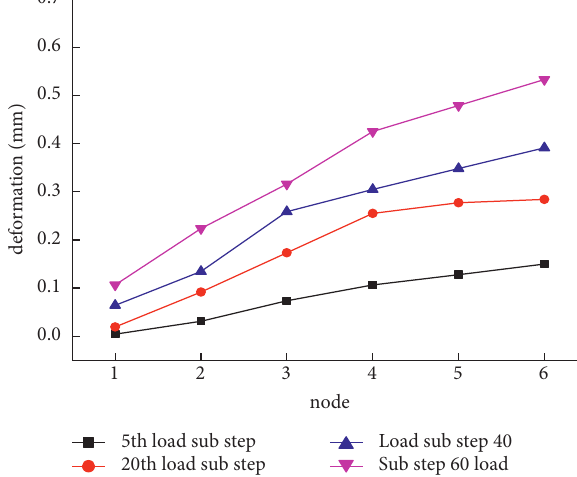
Figure 10: Node deformation on path B.